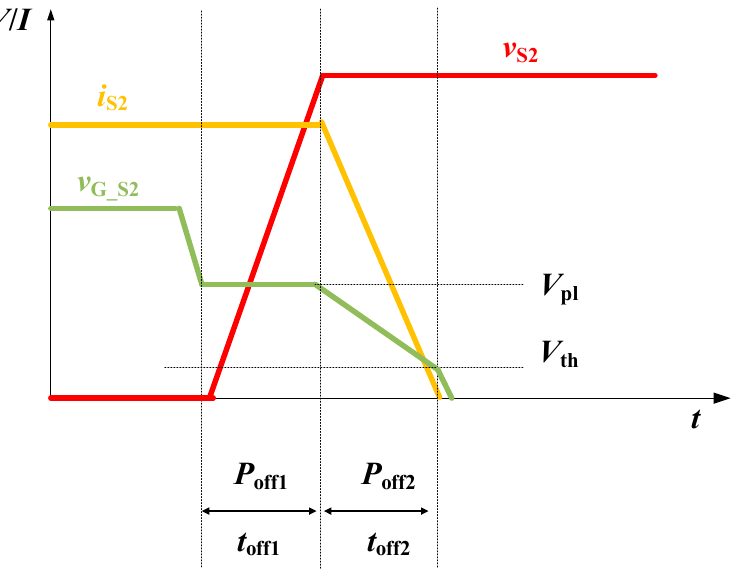
Figure 8. Current and voltage waveforms during the turn-off transition.